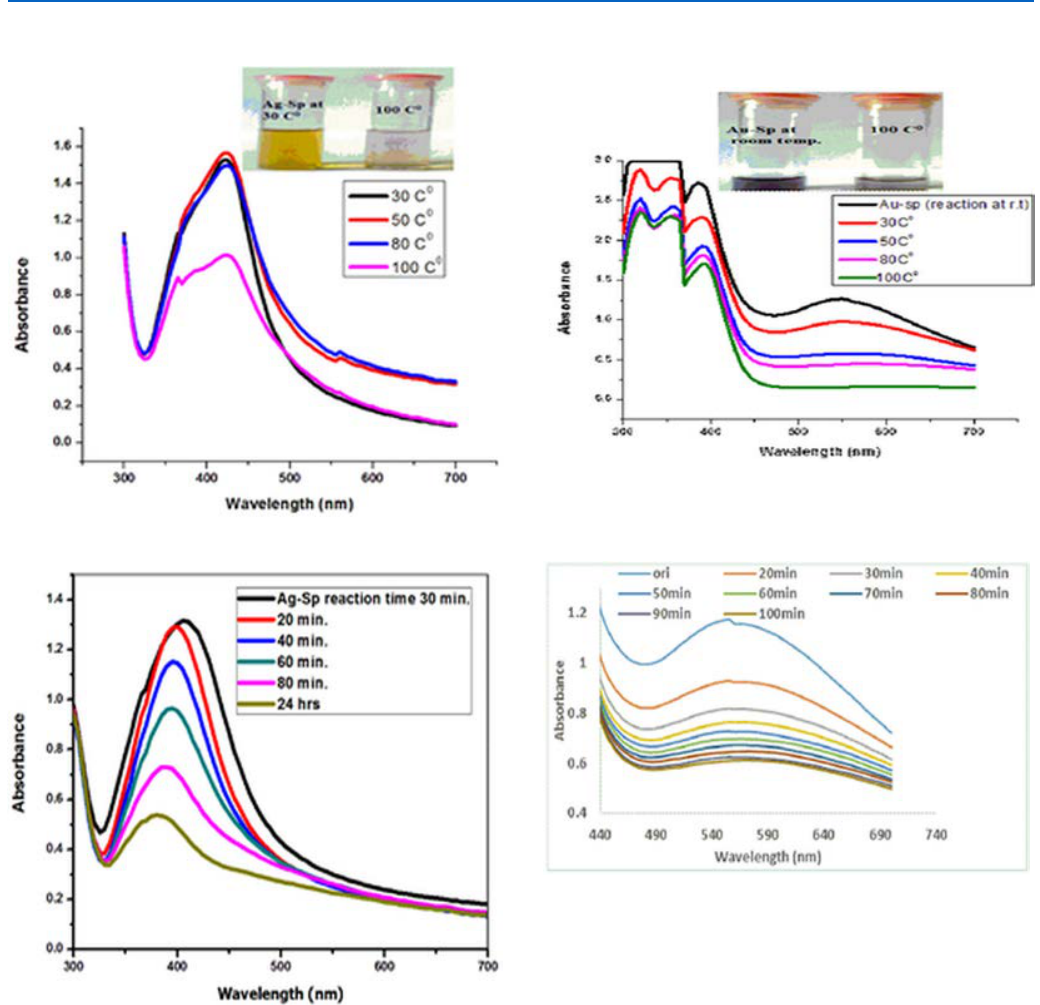
Fig. 6. UV-Vis spectra showing the impact of different volumes of NaCl on stability of Ag-Sp NPs (a) and Au-Sp NPs (b) insets show the change in color of Ag and Au NPs solutions with varying salt (1 M NaCl) concentration correspond to their absorption spectra. Spectral data for the effect of pH on the stability of sparfloxacin-capped Ag NPs (c). Effect of pH on stability of Au-Sp NPs (d). Effect of temperature on the stability of Ag-Sp NPs (Inset: effect of temperature on color of Ag-Sp NPs) (e). Temperature effect on the stability of Au-Sp NPs (Inset: effect of temperature on color of Au-Sp NPs) (f). Effect of reaction time on stability of Ag-Sp NPs (g), and Au-Sp NPs